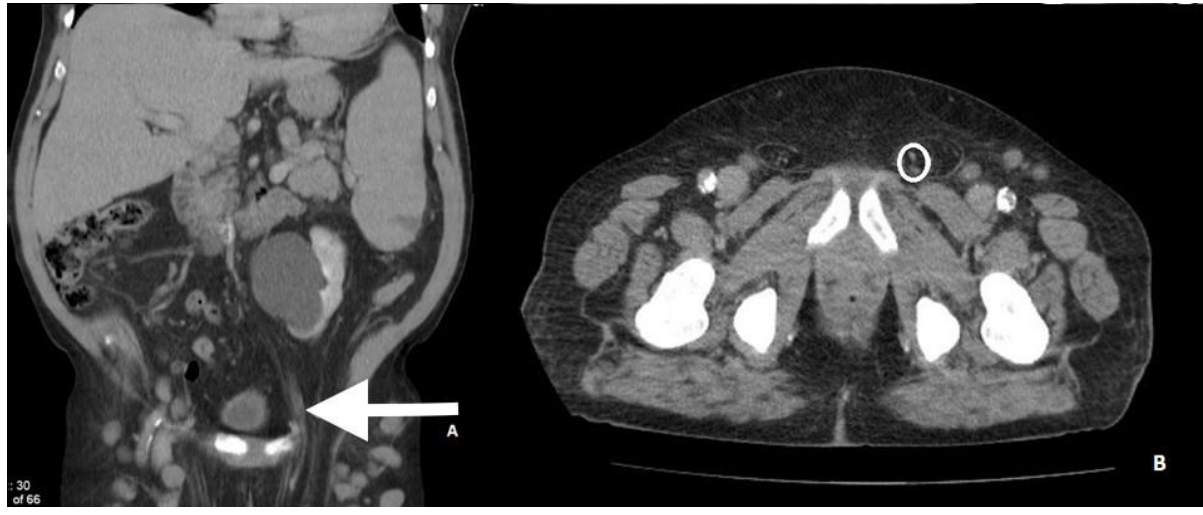
Figure 1. A: Coronal CT showing left ureter entering hernia sac. Left kidney inferiorly displaced. B: Sagital CT showing left ureter entering and leaving the hernia sac.